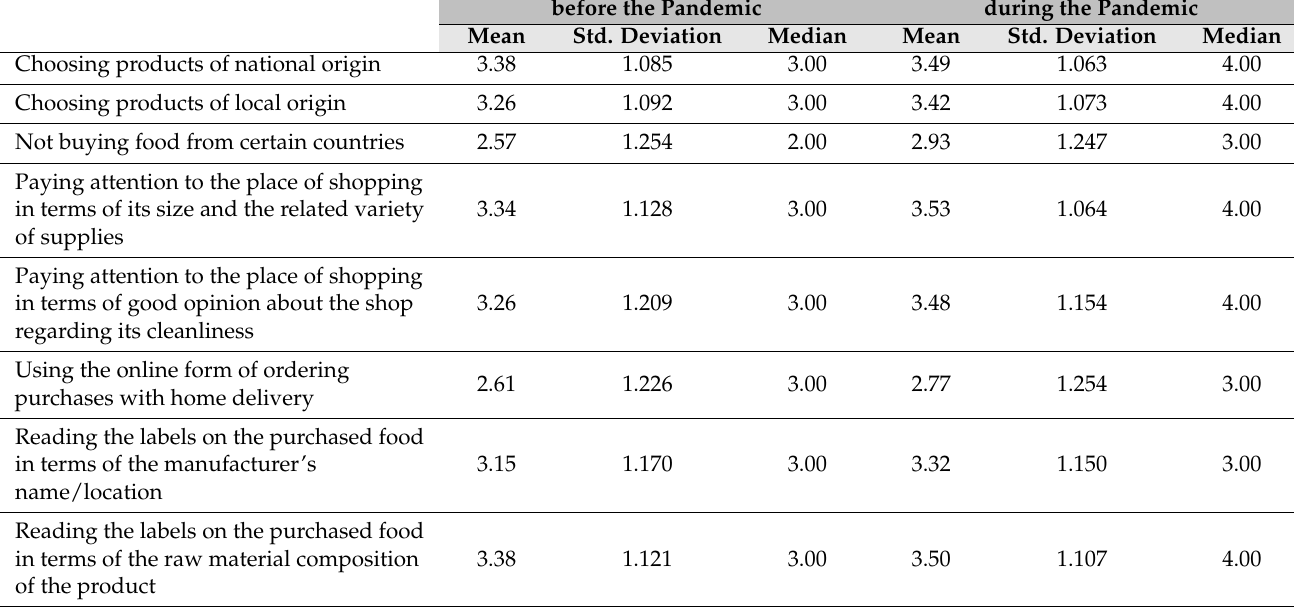
Table 5. Descriptive statistics of the examined